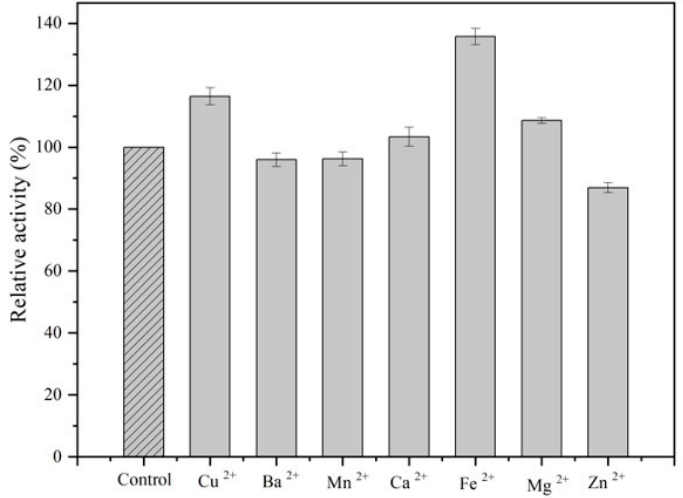
Figure 6. Effect of metal ions on ALDC activity at 30 °C and pH 6.0. Results correspond to the average of triplicate experiments ± standard deviation. Relative activity is expressed as a ratio of the control activity.